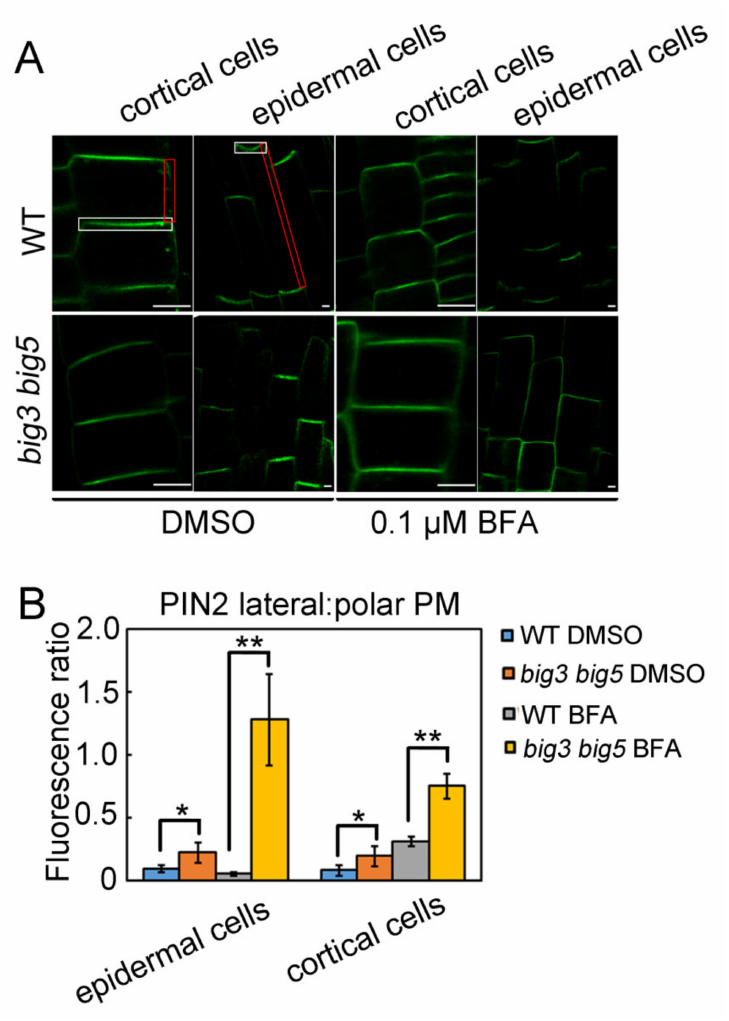
Figure 3. PIN2 polarity of big3 big5 roots is sensitive to BFA. ( A ) seedlings germinated on 1/2 MS medium for 2 days were transferred to the medium containing 5 µ M DMSO (control) or 0.1 µ M BFA for additional 5 days. The GFP signals were analyzed with confocal microscope. Bars = 10 µ m. ( B ) quantification of lateral to polar plasma membrane signal as shown from ( A ). Red rectangles indicate lateral plasma membrane and white rectangles indicate lateral plasma membrane. The significant difference was calculated by a two-tailed Student’s t test, *, p < 0.05, **, p < 0.001. Images are representative from three